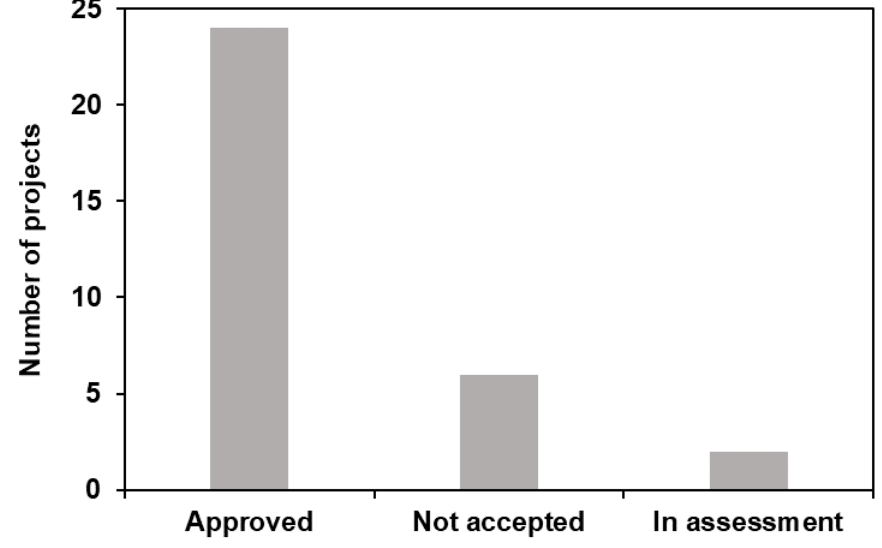
Figure 2. Number of desalination projects submitted to SEIA in Chile between 1997 and 2018 categorized by their status (approved, not accepted, and under assessment).